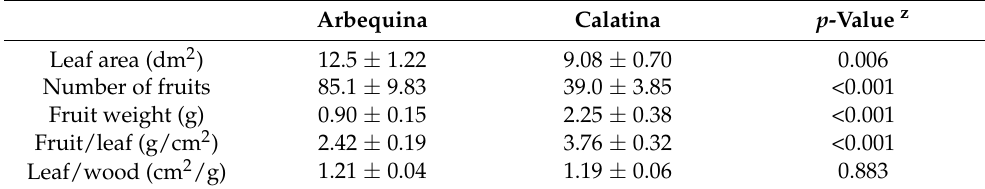
Figure 4. Percentage of leaf, fruit, and wood in two-year-old bearing branches from ‘Arbequina’ and ‘Calatina’ olive trees. Different letters indicate significant differences between cultivars for each branch component (Tukey’s test, p < 0.05). Table 2. Leaf area, number of fruits, average fruit weight, and source–sink ratios in two-year-old bearing branches from ‘Arbequina’ and ‘Calatina’ olive trees.